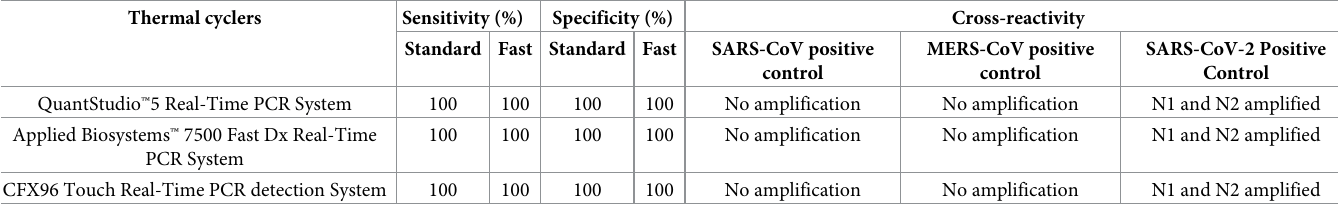
Table 4. Performance evaluation of fast PCR in terms of sensitivity, specificity, and cross-reactivity. Thermal